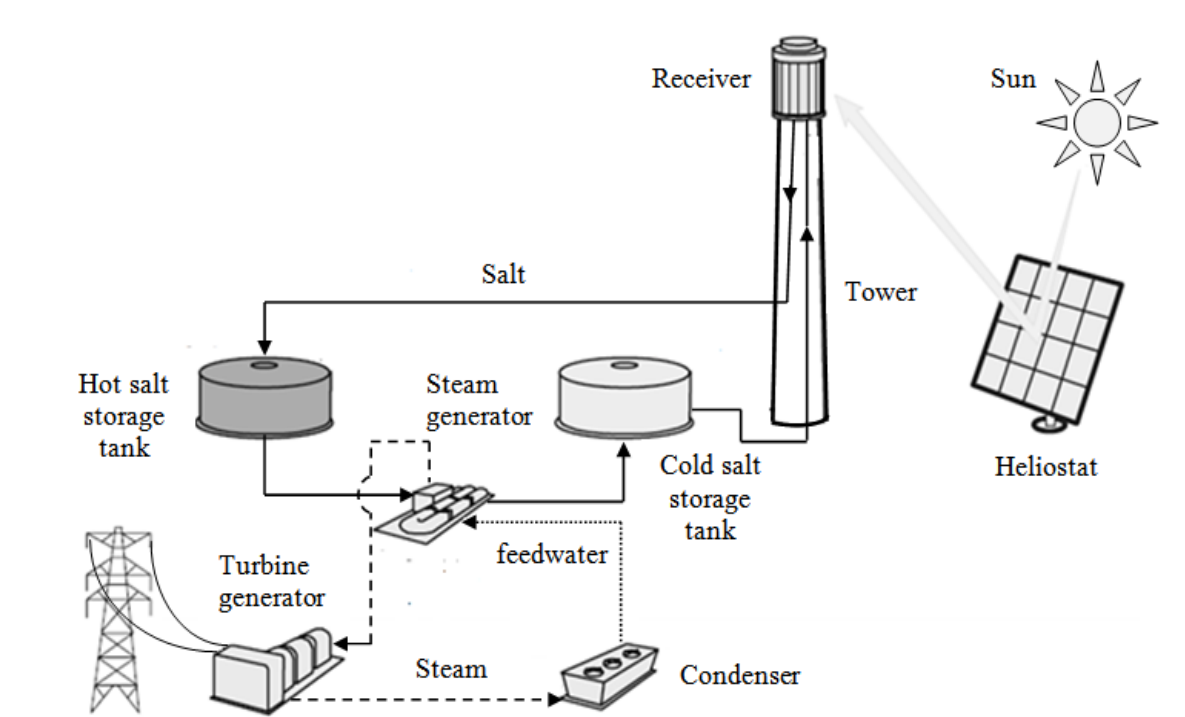
Figure 1. Schematic of a solar tower power plant.